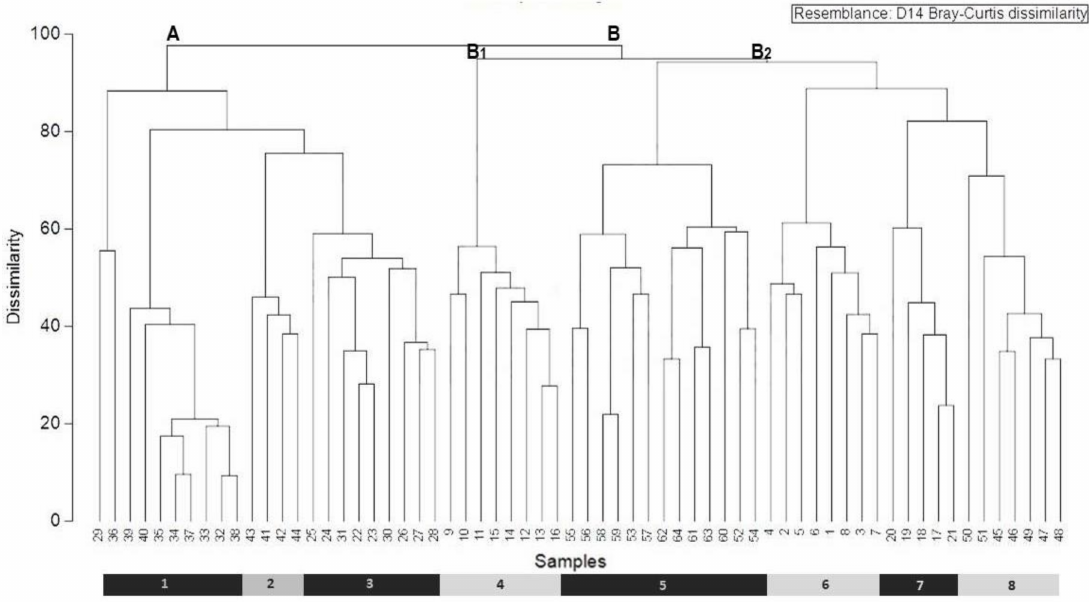
Figure 2. Classification analysis (UPGMA clustering dendrogram (with Bray–Curtis distance) on chasmo-chomophytic asso- ciations from the Southwestern Iberian Peninsula (included in both Rumici indurati-Dianthion lusitani and Calendulo lusitanicae- Antirrhinion linkiani alliances): 1— Silene acutifoliae-Dianthetum lusitani (32–40); 2— Sileno montistellensis-Dianthetum lusitani (41–44); 3— Digitali thapsi-Dianthetum lusitani (22–31); 4— Antirrhinetum onubensis (9–16); 5— Sileno